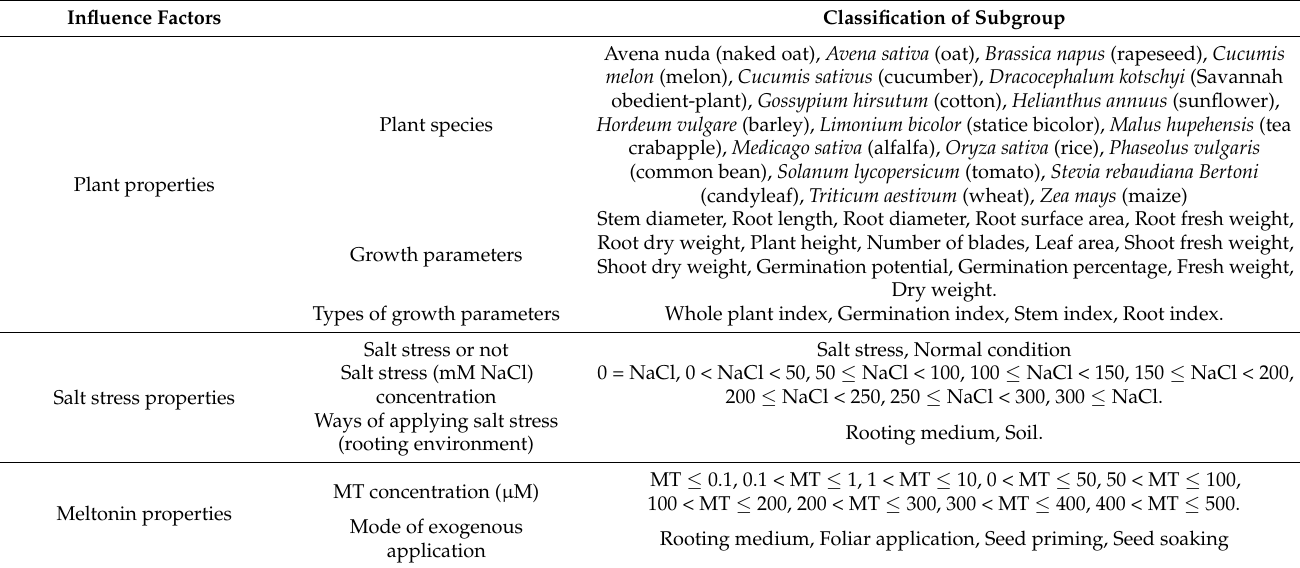
Table 1. Factors categorized as predictive variables in this